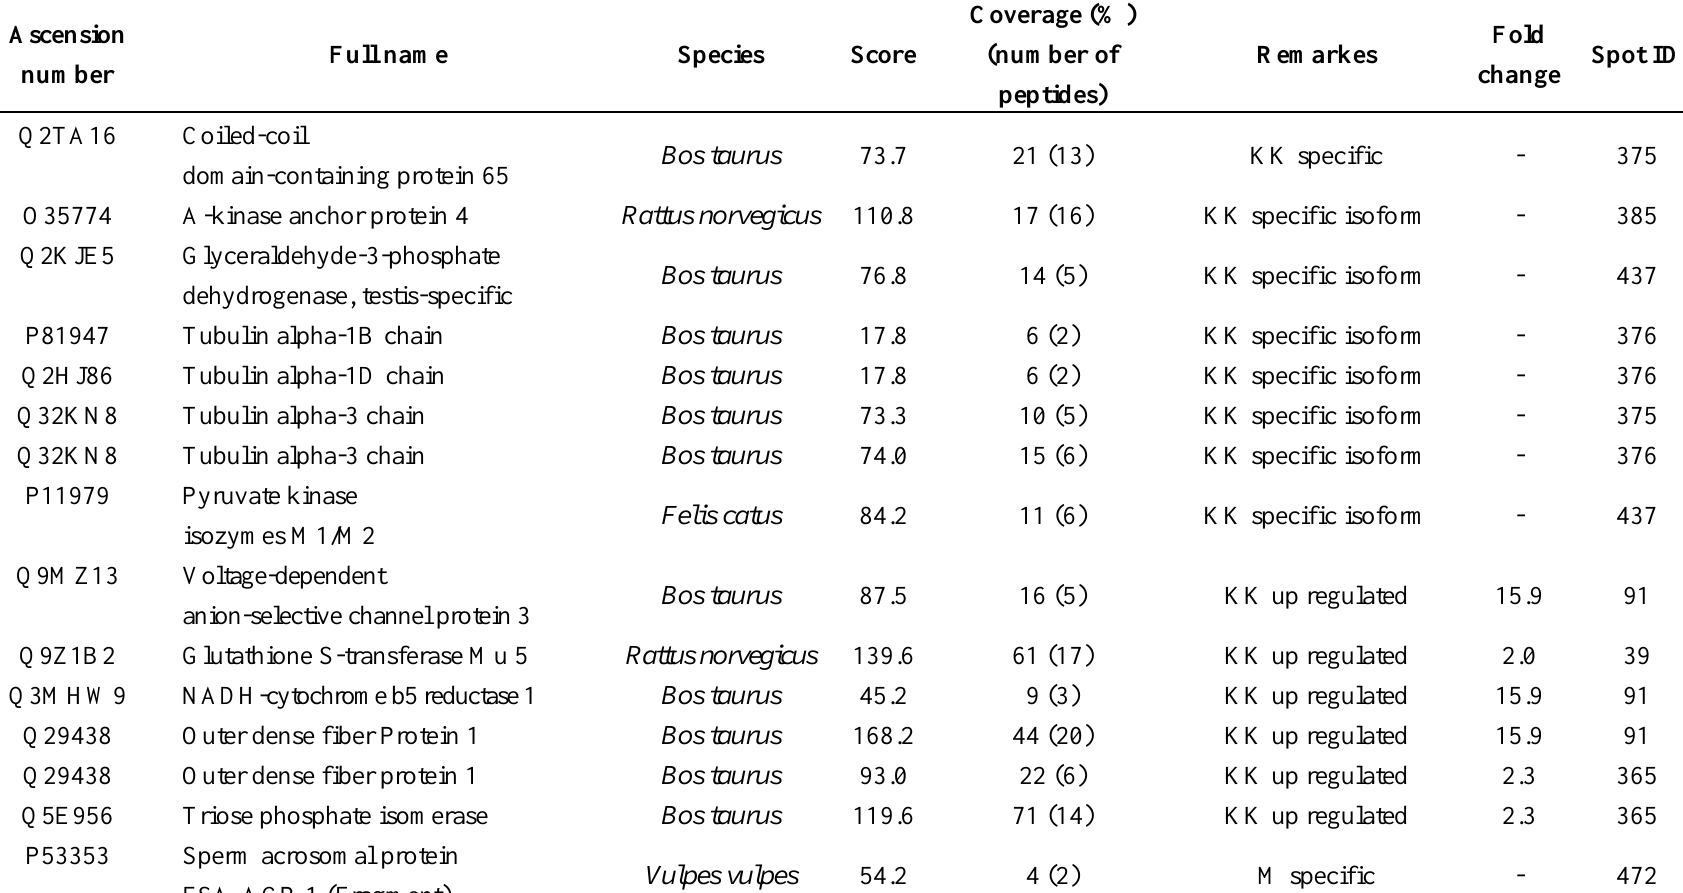
Table 1. Proteins identified using LC MS/MS